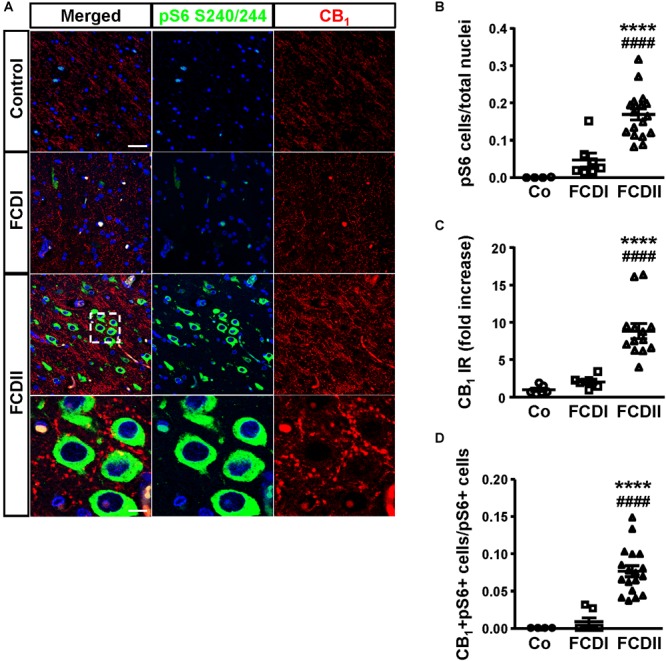
The CB1 receptor is enriched in focal cortical dysplasia (FCD) Type II in cells with overactive mTORC1 signaling. (A) Representative immunofluorescence images showing the presence of CB1 receptors in samples from Type I and II FCD and control brains, revealed with an anti-CB1 antibody (red). Cells with over-active mTORC1 signaling are stained with phospho-S6Ser240/244 antibody (green). High magnification images of CB1 receptor expression associated with mTORC1 overactivation in FCD Type II are shown. (B,C) Phospho-S6+ cells and CB1 receptor immunoreactivity (IR) were quantified in the dysplastic area and referred to total cell number (DAPI counterstaining). Control, FCD Type I and FCD Type II cases (B, n = 4, 7 and 18, respectively; C, n = 6, 8, 13). (D) CB1+ phospho-S6+ double-labeled cells were quantified and referred to total pS6+ cells. Control, FCD Type I and FCD Type II cases (n = 4, 7, and 18, respectively). Statistical comparison versus control samples, ∗∗∗∗p < 0.0001; statistical comparison versus FCD Type I samples, ####p < 0.0001. Scale bar 45 μm, insets, 10 μm.